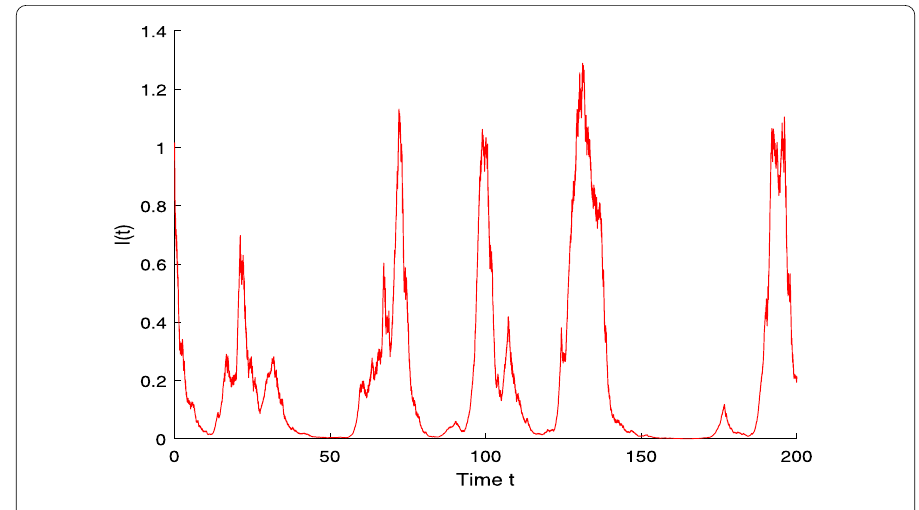
Figure 1 The sample path of I ( t ) with S (0) = 2, I (0) = 1. Here α (1) = 0.1 and α (2) = 0.15. In this case, β ( i ) > α ( i )( ε ( i ) + γ ( i )), i ∈ S